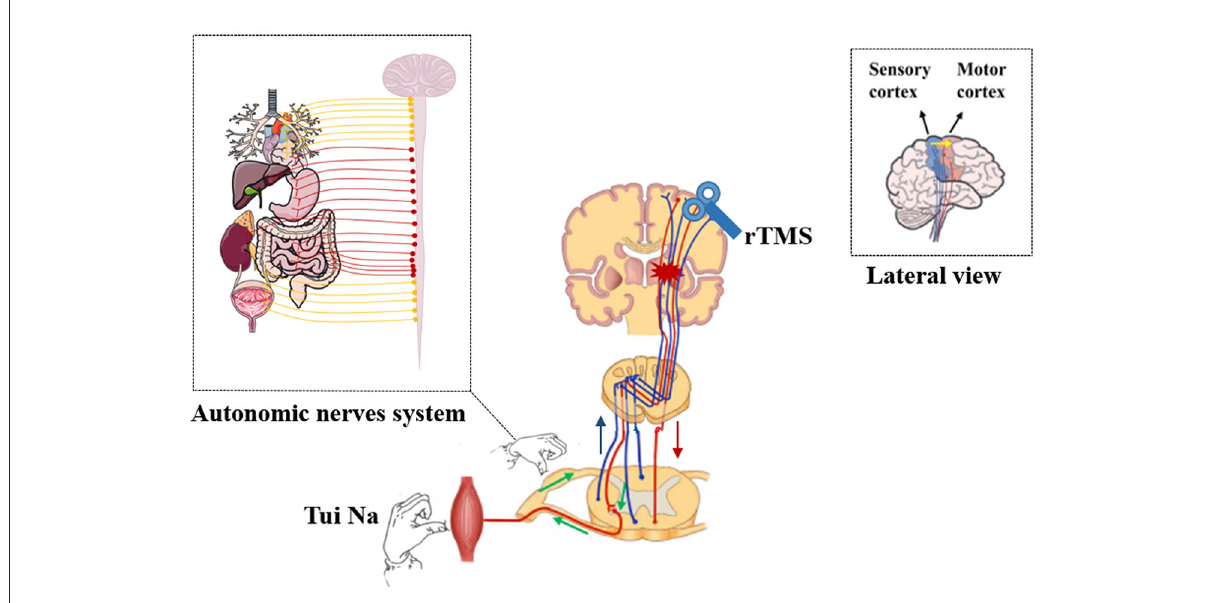
FIGURE2 rTMS synergize with Tui Na